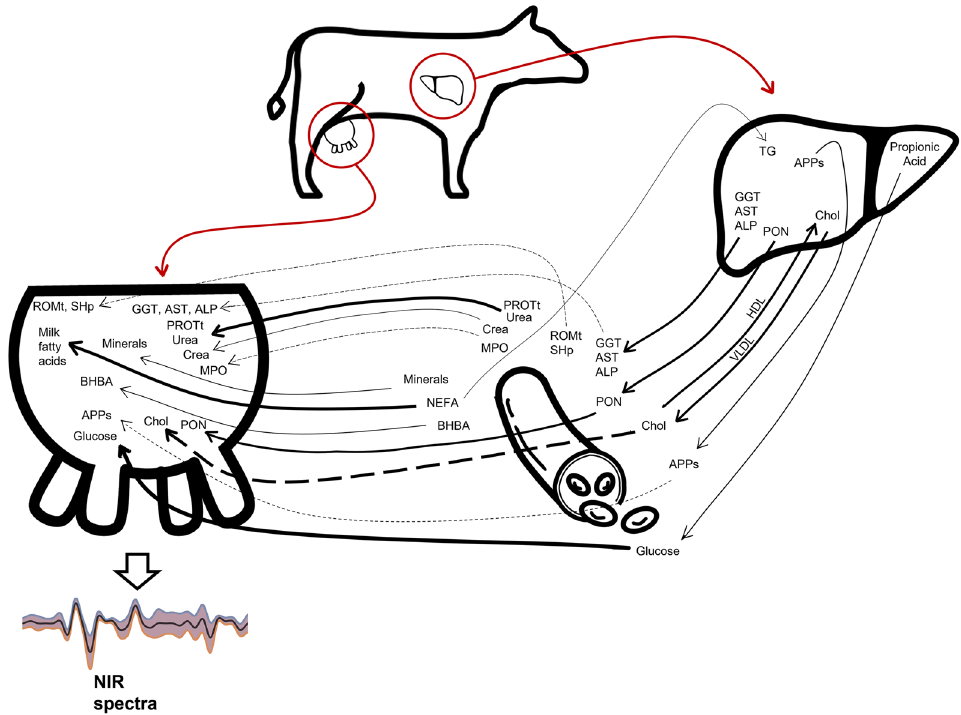
Figure 2. Origin of substances present in mammary gland of dairy cows captured with near-infrared (NIR) spectra and relationships with blood stream and liver. The thick arrows represent gross transfer between compartments during lactation; in the mammary gland, the metabolites involved in these processes are mainly derived from blood flow. The thin arrows denote minor fluxes. Dashed lines represent fluxes of metabolites that are partly originated from the blood stream and partly secreted directly by mammary gland. During lactation, circulating non esterified fatty acids (NEFA) are regularly incorporated into milk fat; circulating NEFA in excess are stored in the liver as triglycerides (TG). Cholesterol (Chol) in the mammary gland originates from blood uptake and, to a certain extent, from local synthesis in the mammary tissue. Propionic acid represents the substrate for gluconeogenesis: the mammary gland absorbs large amounts of glucose from blood flow to synthetize lactose, enhance viability and proliferation of the mammary cells, and supply energy for synthesis of milk components. Acute phase proteins (APPs), including haptoglobin and ceruloplasmin, are mainly synthetized in the liver and are able to pass through the blood-mammary barrier in case of systemic inflammatory conditions or, when local processes are active, they could be self-produced by the mammary epithelium. ALP alkaline phosphatase, AST aspartate aminotransferase, BHBA β-hydroxybutyric acid, Crea creatinine, GGT γ-glutamyl transferase, HDL high density lipoproteins, MPO myeloperoxidase, PON paraoxonase, PROTt total proteins, ROMt total reactive oxygen metabolites, SHp thiolic groups, VLDL very low density